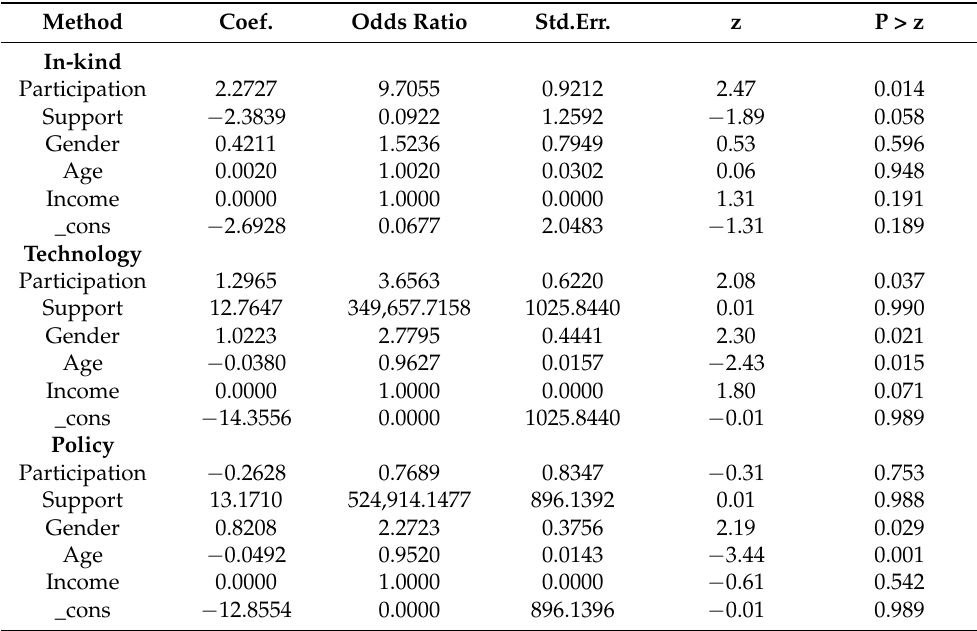
Table 4. Results for MNL model on farmers’ questionnaire